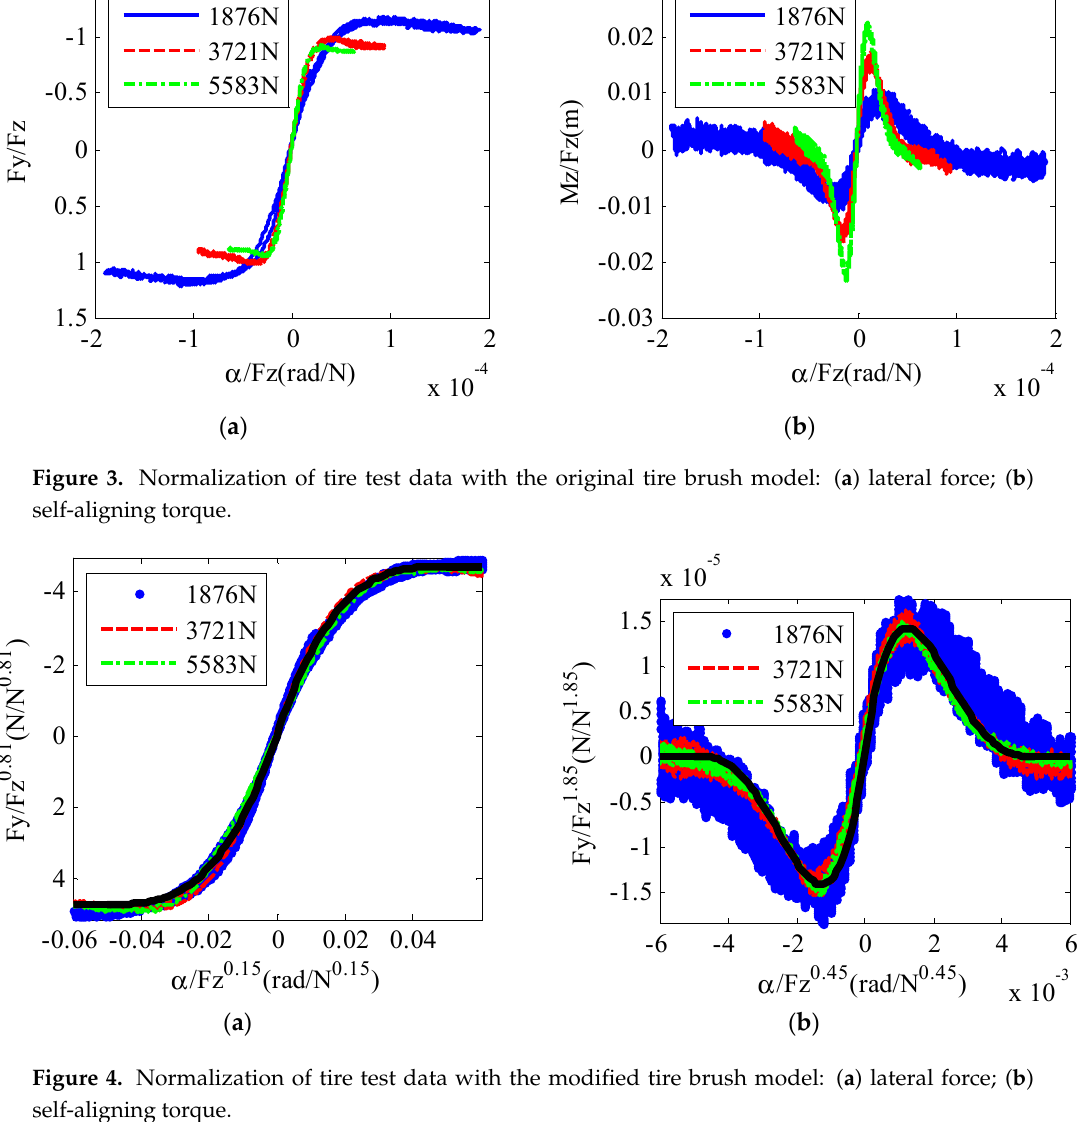
Figure 4. Normalization of tire test data with the modified tire brush model: ( a ) lateral force; ( b ) self-aligning torque.